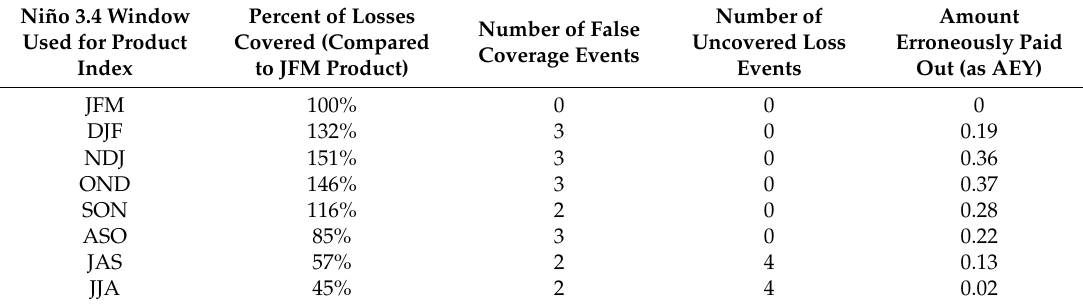
Table 1. Percent losses covered, basis risk events, and erroneous payments for product conditioned on observed Niño 3.4 values from incrementally shifted seasonal windows.